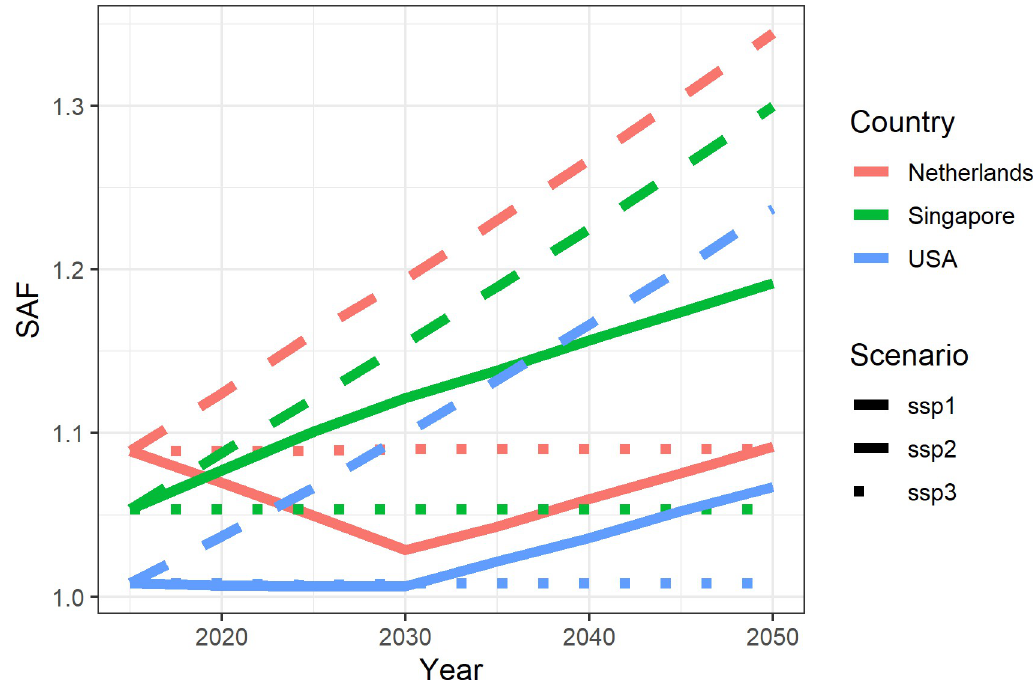
Fig 1. Projection of SAF of 15–19 age group, several scenarios, 2015–2050. Source: Authors’ own calculations.